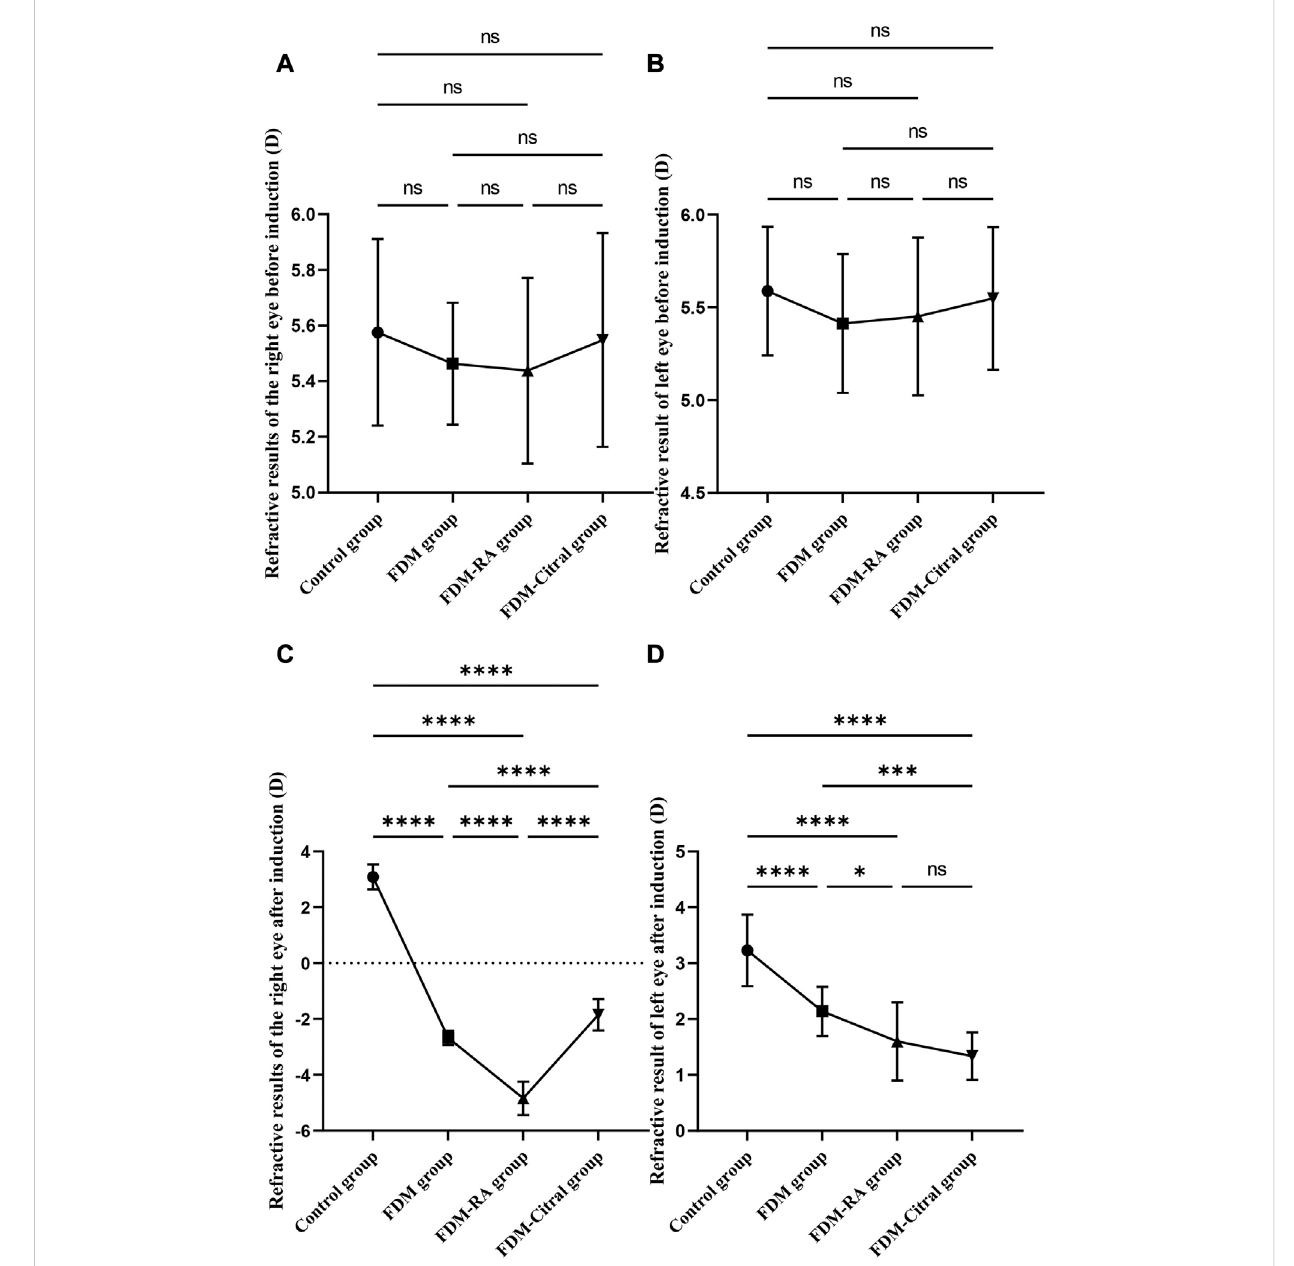
FIGURE 2 Comparative results of RE before and after induction in four groups (D). Note. (A) , Comparison of RE in the right eye before induction; (B) , Comparison of RE in the left eye before induction; (C) , Comparison of RE in the right eye after induction; (D) , Comparison of RE in the left eye after induction; (D) , diopter; ns means that the difference is not statistically signi fi cant; *Indicates p ≤ 0.05; ** Indicates p ≤ 0.01; *** Indicates p ≤ 0.001; **** Indicates p ≤